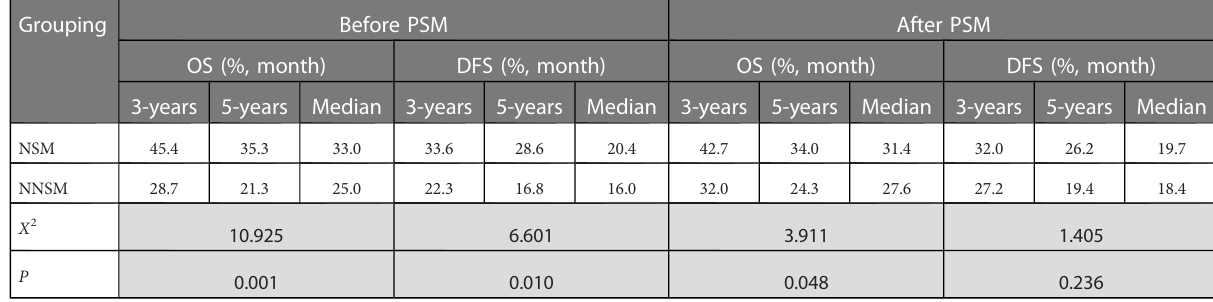
TABLE 4 Analysis results of prognosis of patients with different sites of metastatic nodes before and after PSM. Grouping Before PSM After